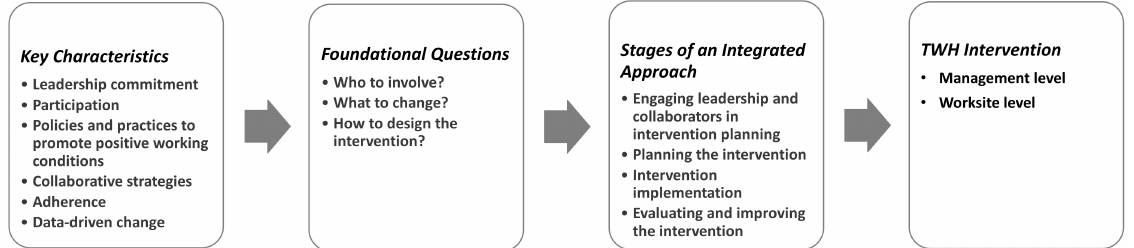
Figure 1. The Implementation Guideline’s six key characteristics helped us answer the three questions that created the foundation of intervention. Those three questions informed our decision-making at each of the four stages from the Guidelines, leading to the design of a multilevel